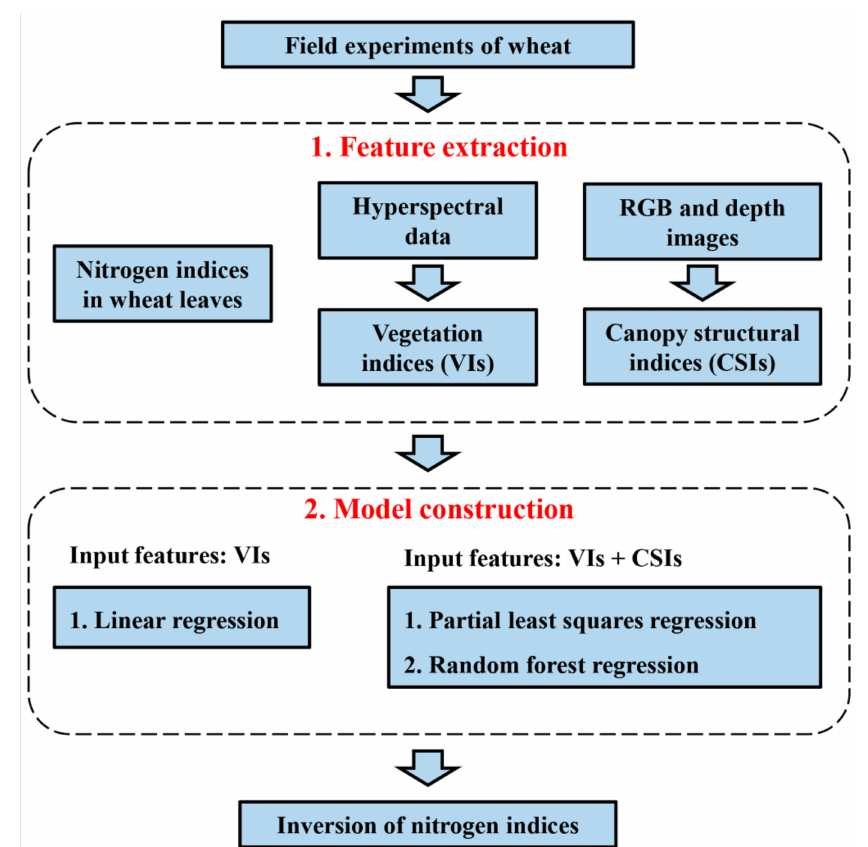
Figure 2. Flowchart of this